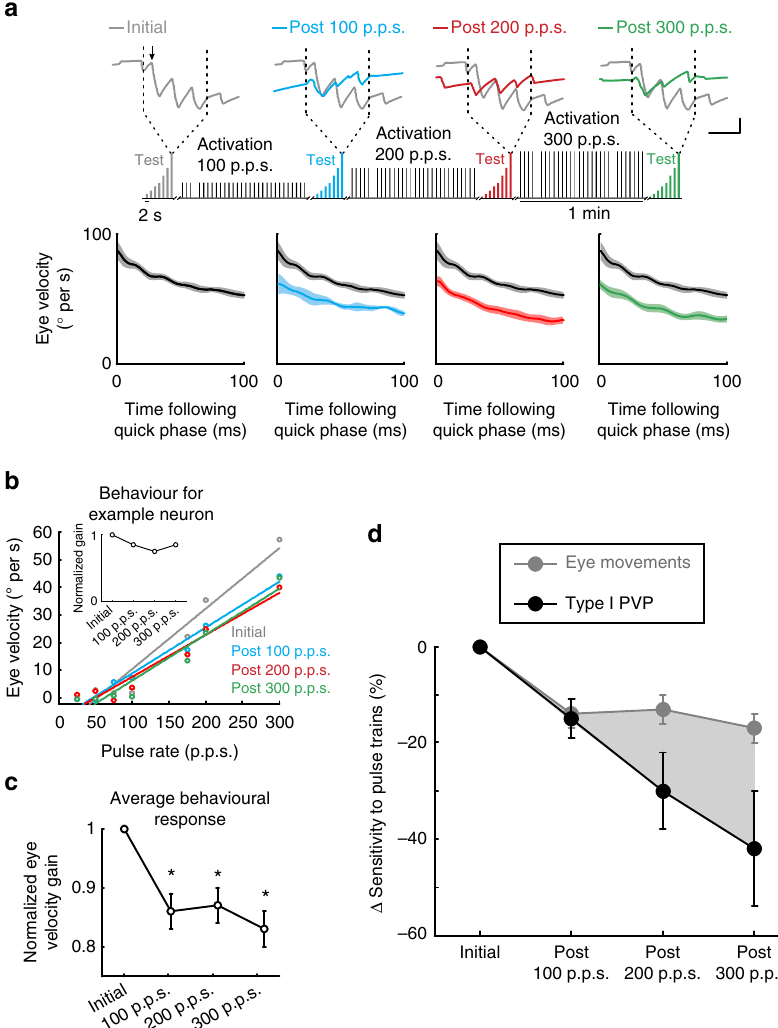
Figure 4 | Eye movement responses decrease following activation of the vestibular nerve. ( a ) Top panel: eye position traces during test stimuli at 300p.p.s. before and after activation of the vestibular nerve. Inset shows schematic of electrical stimulation protocols. Arrow highlights example quick phase. Bottom panels: averaged eye velocity over the 100ms following each saccade that occurred throughout the 1s of stimulation at 300p.p.s. Calibrations bars, 10 (cid:2) , 0.5s. ( b ) Average eye velocity (restricted to periods of compensatory VOR) as a function of pulse rate for the corresponding eye movements recorded with the example neuron in Fig. 2. Inset shows normalized gain (slope of eye velocity versus pulse rate). ( c ) Average normalized gain across all trials ( n ¼ 61). * P o 0.05 (Student’s t -test). ( d ) Comparison between decrease in sensitivity for type I PVP and eye movement responses. Error bars and shaded area represent ±